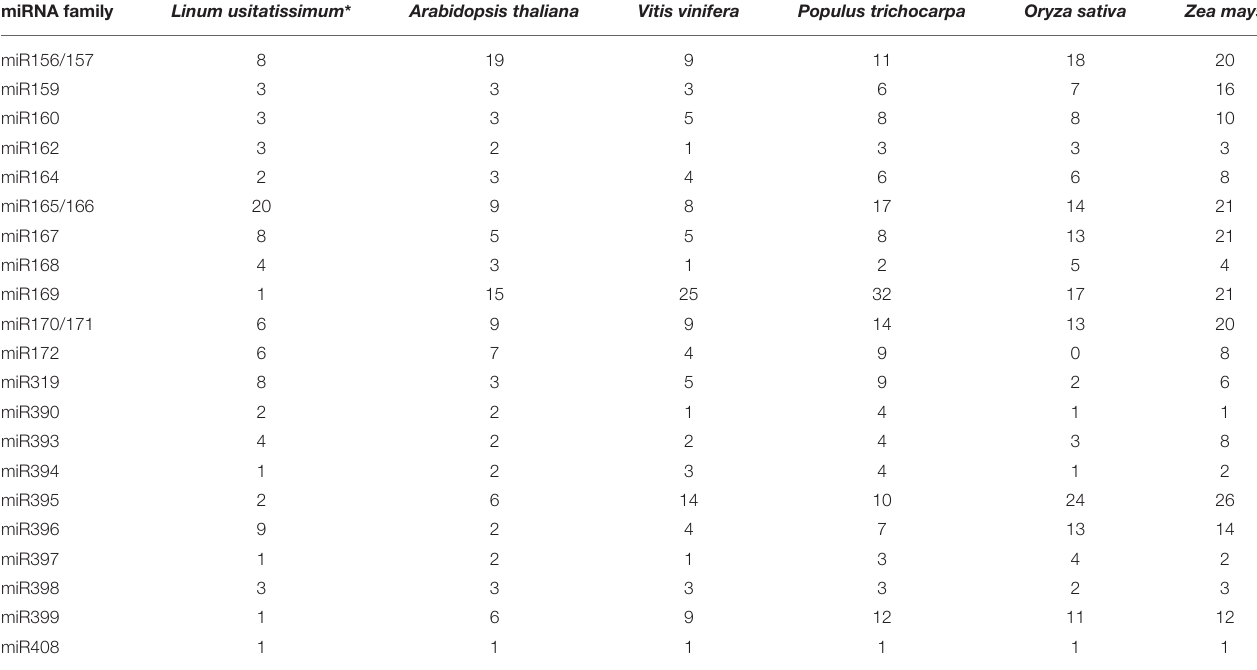
TABLE 3 | Number of miRNA family members for L. usitatissimum and other plant species according to miRBase 19.0. miRNA family Linum usitatissimum * Arabidopsis thaliana